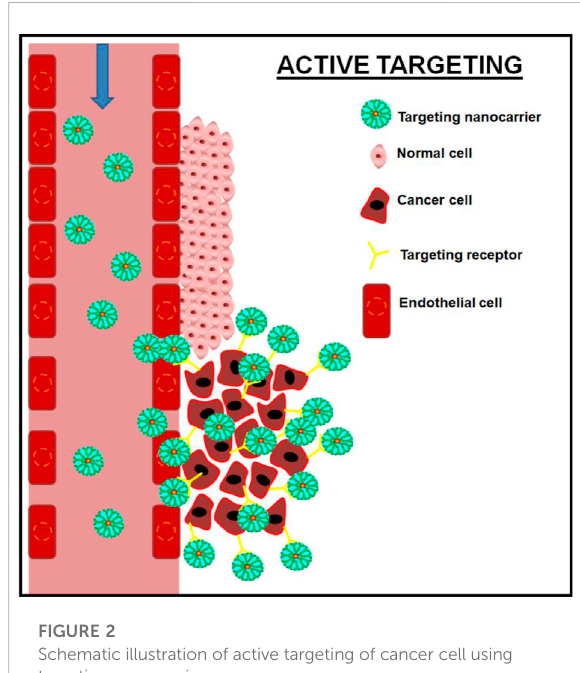
FIGURE 1 Schematicillustrationofpassivetargetingofcancercellusing non-targeting nanocarrier.